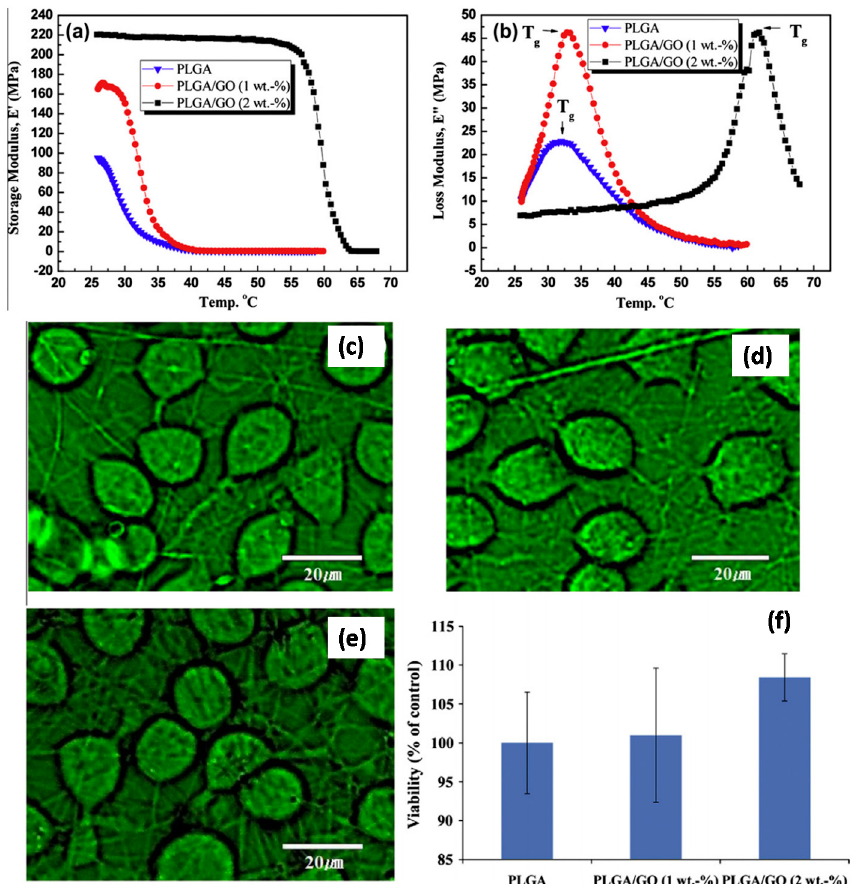
Figure 26. Dynamic mechanical analyzer curves as a function of measurement temperature. ( a ) Storage modulus and ( b ) loss modulus. For PLGA, PLGA/GO (1 wt%), and PLGA/GO (2 wt%) nanofibers. Optical microscope images of PC 12 cells on ( c ) PLGA nanofibers; ( d ) PLGA/GO (1 wt%) nanocomposites; ( e ) PLGA/GO (2 wt%) nanocomposites; and ( f ) cell proliferation and viability data obtained by WST-1 assay of the cells cultured for 2 days ( n = 12, p <0.05) [85].